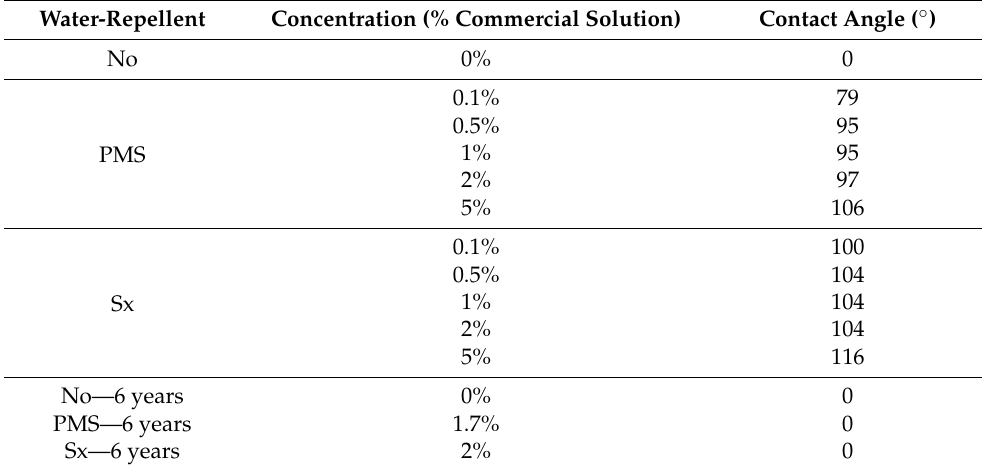
Table 1. Apparent contact angles measured on tiles after water-repellent coatings of siliconate (PMS) and siloxane (Sx) (at 0, 0.1, 0.5, 1, 2, and 5%) and after 6 years of exposure. Water-Repellent Concentration (% Commercial Solution) Contact Angle ( ◦ ) No 0% 0